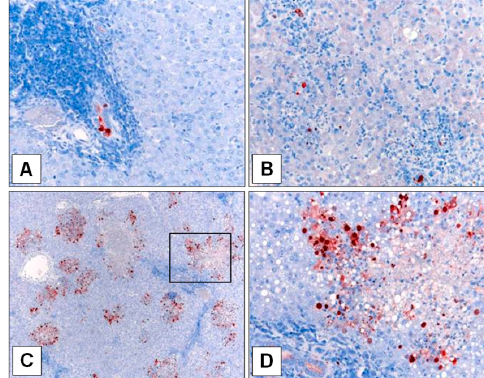
Figure 2. Immunostaining of H5N1 virus in liver samples of infected ferrets. Virus (red) was visualised in ( A ) liver of A/Laos-inoculated ferret F8 on day 5 PI.; ( B ) liver of A/Laos-inoculated ferret F10 on day 7 PI.; ( C ) and ( D ) liver of A/Viet-inoculated ferret F18 on day 5 PI. Boxed area in ( C ) denotes image shown in ( D ). Magnifications ( A ) 20×; ( B ) 20×; ( C ) 5×; ( D ) 20×.